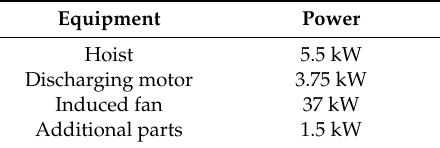
Table 2. Power parameters of the primary